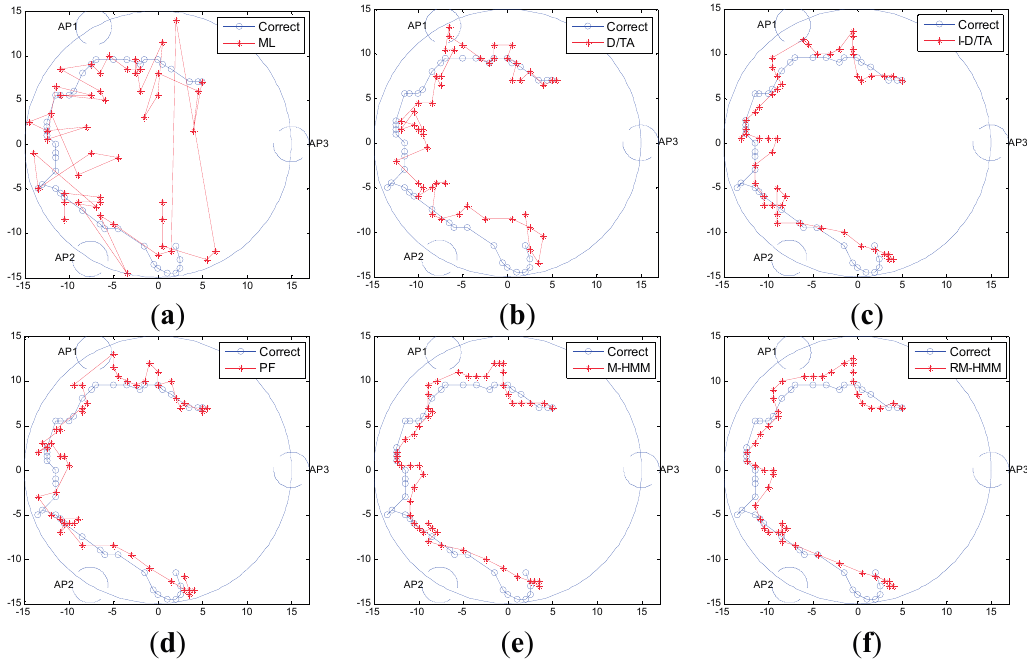
Figure 12. Simulation trajectory of various algorithms: ( a ) Trajectory estimated by the ML algorithm; ( b ) Trajectory estimated by the D/TA estimation in [16]; ( c ) Trajectory according to I-D/TA estimation; ( d ) Trajectory estimated by the PF algorithm; ( e ) Trajectory estimated